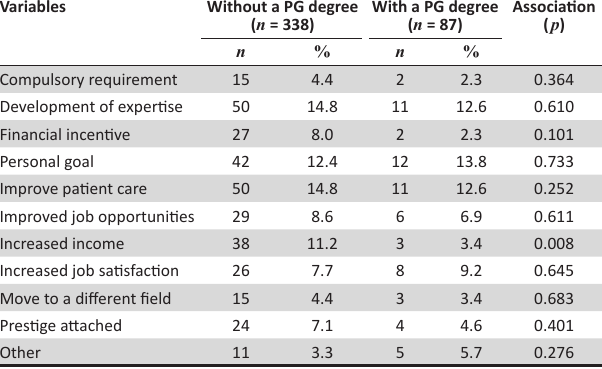
TABLE 3: Facilitators to postgraduate